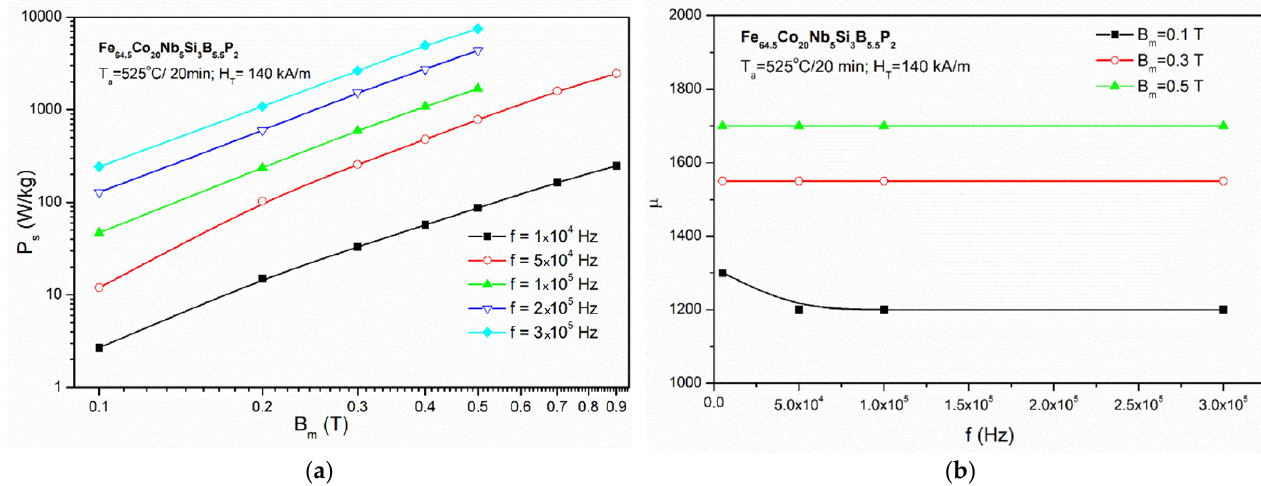
Figure 15. ( a ) Core losses (P s ) for the Fe 64.5 Co 20 Nb 5 B 8.5 P 2 core as a function of magnetization (B m ) for 10–300 kHz; ( b ) magnetic permeability ( µ ) for the Fe 64.5 Co 20 Nb 5 B 8.5 P 2 core as a function of frequency for B m = 0.1–0.5 T.